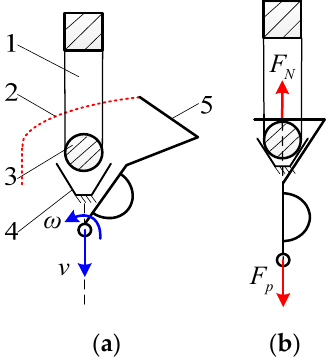
Figure 15. Schematic diagram of the capture scheme ( a ) Released state; ( b ) locked state. 1, capture box; 2(the red dotted line), capture hook vertex trajectory; 3, positioning axis; 4, V-groove; 5, capture hook.